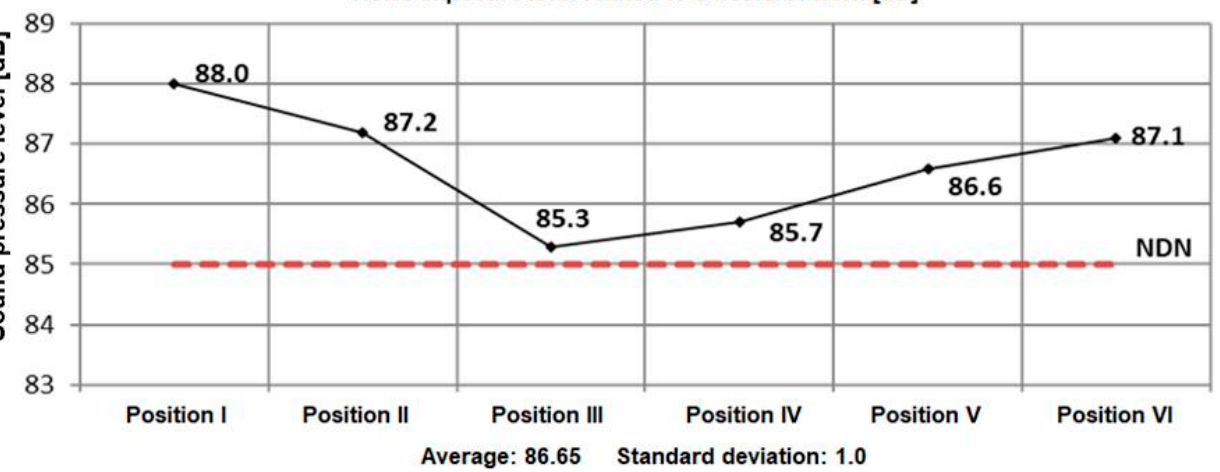
Figure 2. Analysis of the noise level 8 h daily working time ( L ex, 8 h ) in comparison with the acceptable standard (NDN) at the workstation of the mechanical coal processing plant.